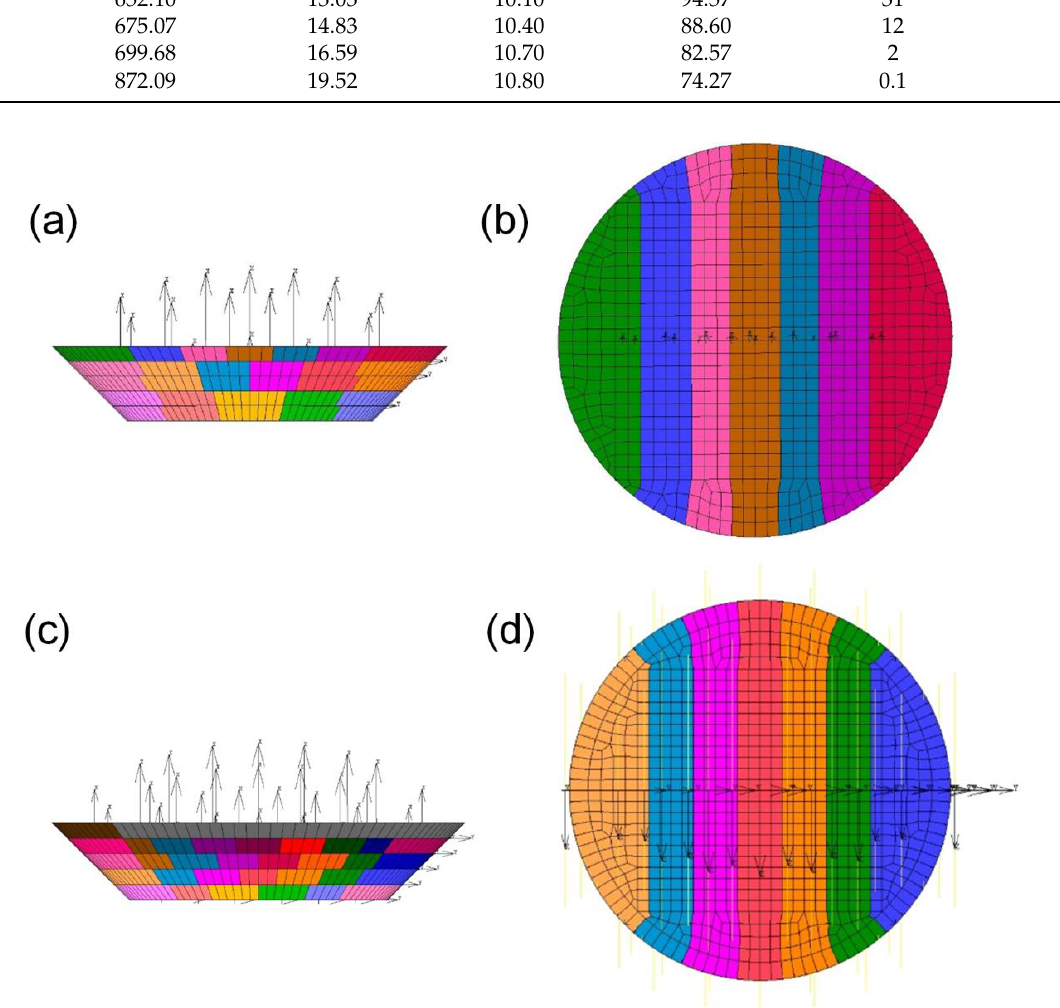
Figure 6. Developed model for numerical simulation, the colors indicate different repairing paths: ( a ) Repaired paths for three layers, ( b ) Top view for developed model, ( c ) Repaired paths for five layers, ( d ) Top view for developed